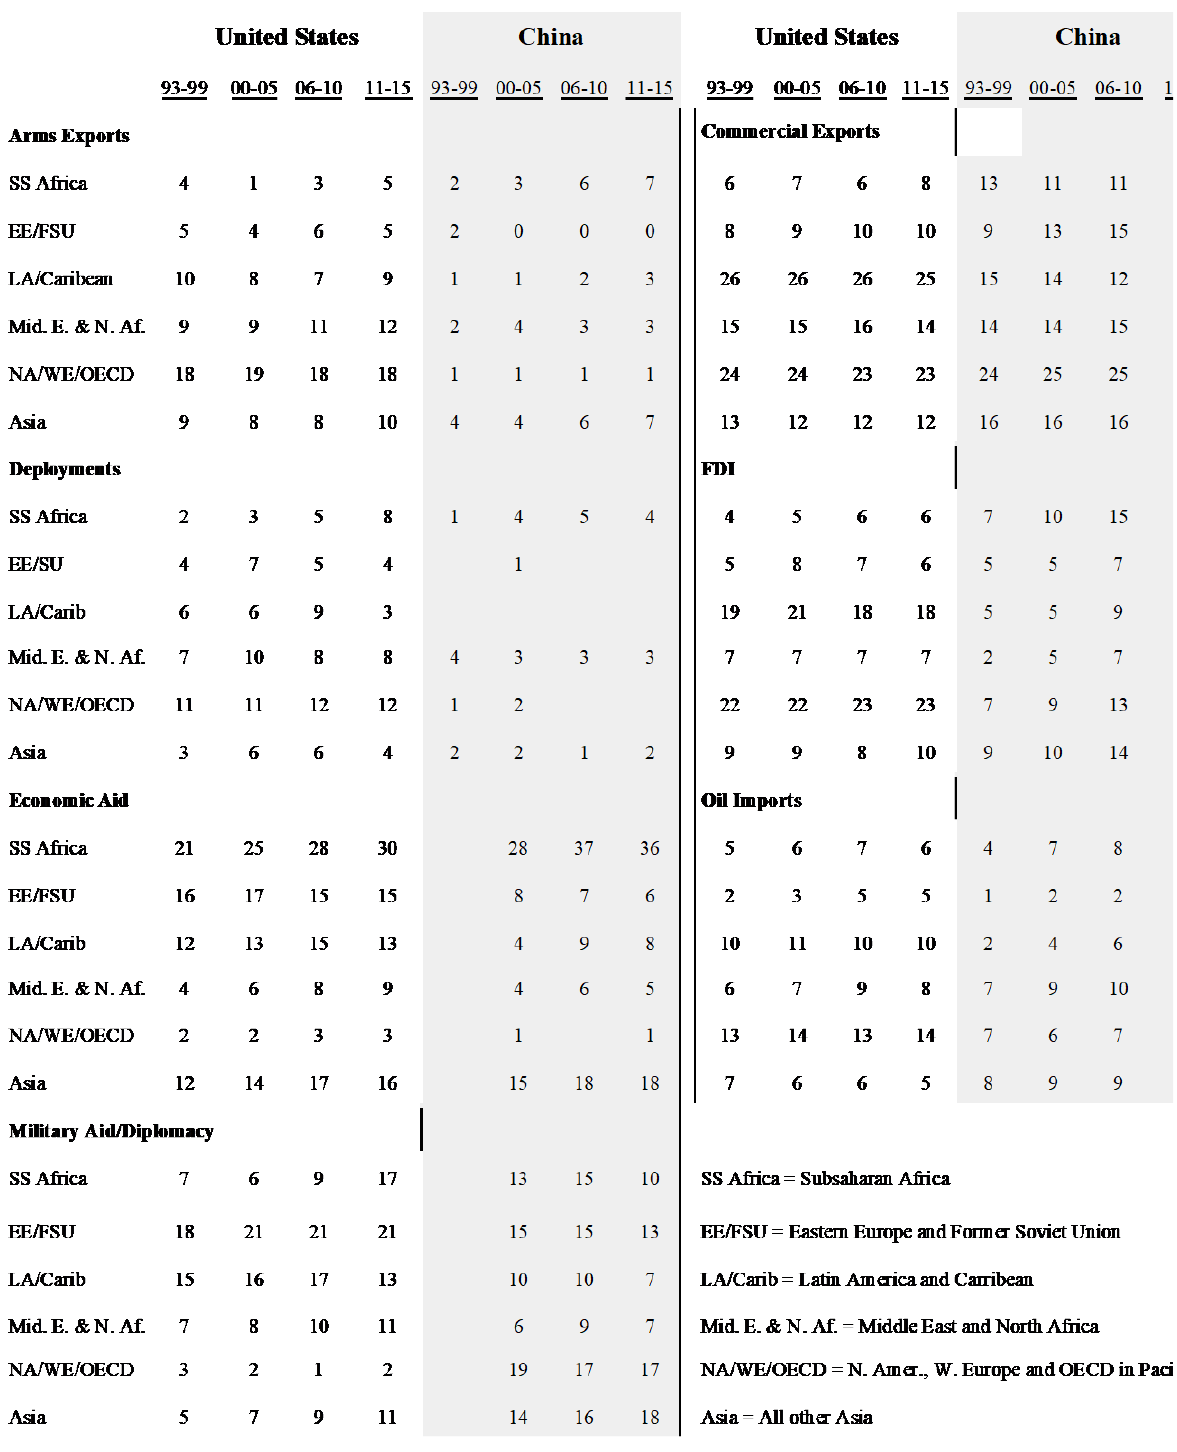
Table 3: Size of U.S. and Chinese economic and political-military networks by region (avg. countries per region per